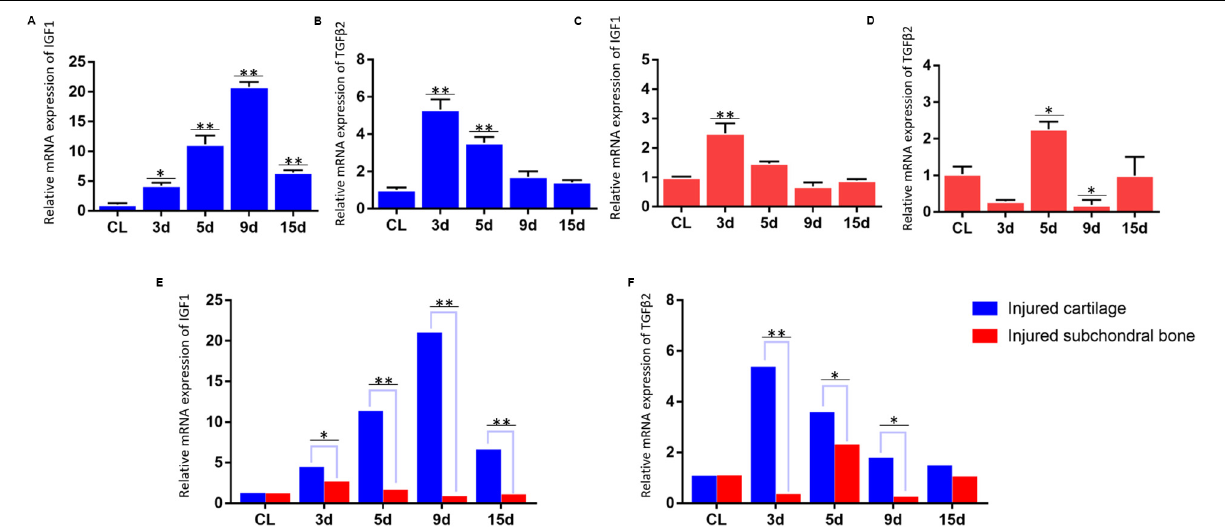
FIGURE 4 | qPCR results for the mRNA expression of IGF1 and TGF β 2. (A,B) Dynamic changes in IGF1 and TGF β 2 mRNA expression in the injured TMJ region at different time points in the first animal model (the articular disc and half condylar cartilage were removed) compared with the control groups (normal cartilage). (C,D) Dynamic changes in IGF1 and TGF β 2 mRNA expression in the injured TMJ region at different time points in the second animal model (the articular disc and total condylar cartilage were removed) compared with the control groups (normal subchondral bone). (E) Comparison of the relative change of IGF1 mRNA in the injured TMJ region between the first animal model and the second animal model at different time points. (F) Comparison of the relative change of TGF β 2 mRNA in the injured TMJ region between the first animal model and the second animal model at different time points. Abbreviation: CL, control; 3 d, 5 d, 9 d, and 15 d indicate 3 days, 5 days, 9 days, and 15 days, respectively; ∗ p < 0.05, ∗∗ p < 0.01.